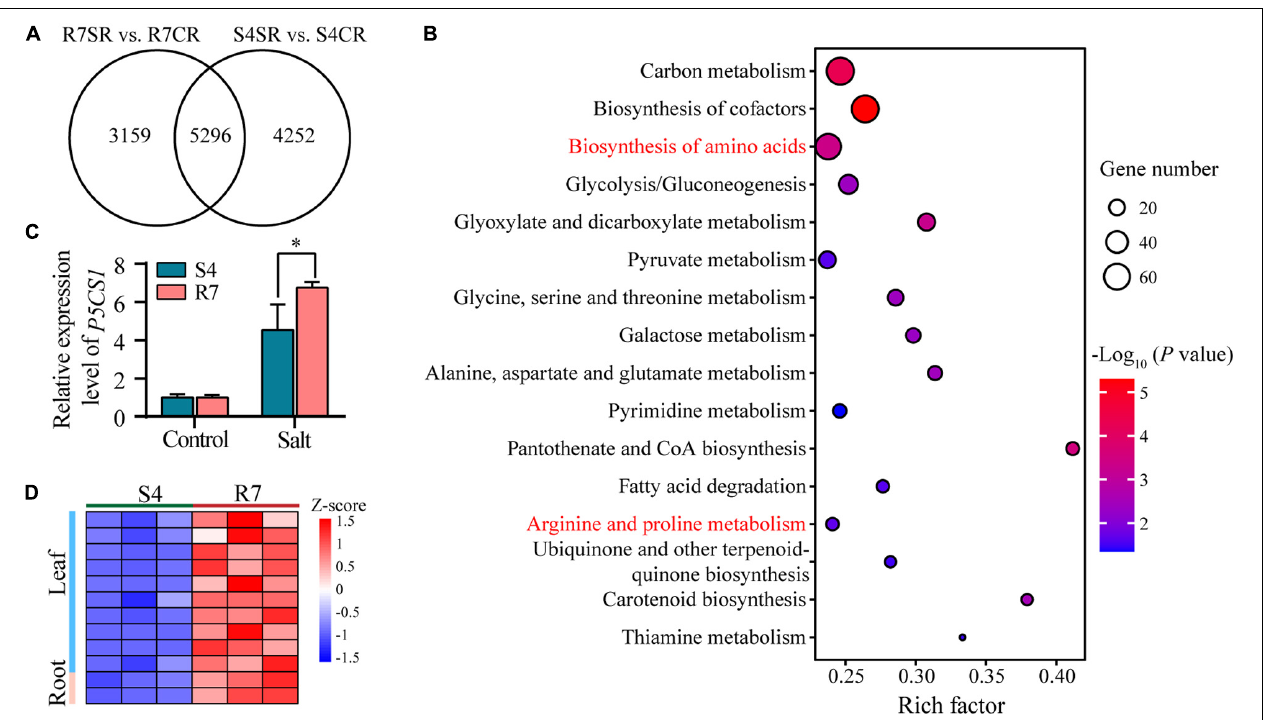
FIGURE 6 | The KEGG pathway enrichment analysis of the shared DEGs between comparisons R7SR vs. R7CR and S4SR vs. S4CR and further analysis of proline metabolism. (A) Venn diagram of DEGs in response to salt stress in F. velutina R7 and S4 roots. (B) The significantly enriched pathways ( P < 0.05). Size of dot represented the number of DEGs and from blue to red represented the P -value from low to high. (C) Detecting the relative expression levels of P5CS1 in F. velutina R7 and S4 roots with or without salt treatment. (D) Relative expression levels of a peroxidase (POD) gene in R7 and S4 roots with or without salt treatment. Heatmap color represented z-score and from blue to red represented the value from low to high. * P < 0.05 represented significant